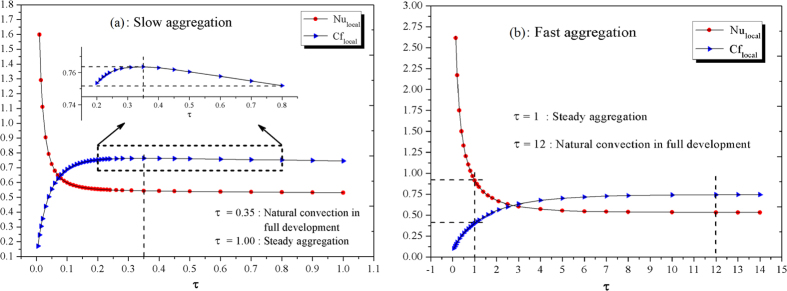
Different aggregation in convection dependence of time.(a) and (b) Both the local skin friction Cflocal and local Nusselt nnumber Nulocal versus demensionless time for slow and fast aggregation, respectively, with ϕp = 0.05 and df = 1.8 conditions.